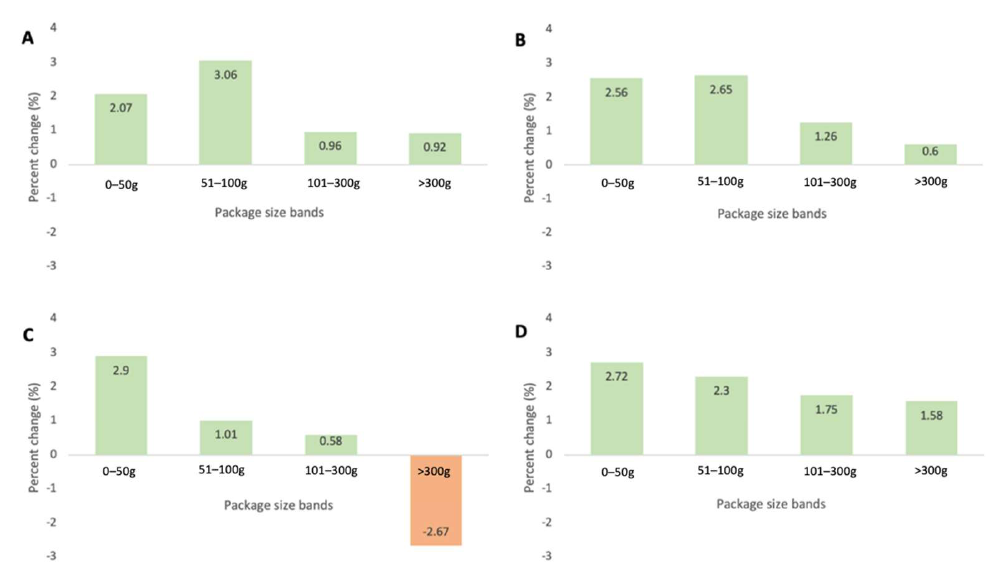
Figure 2. Compound annual growth rate (CAGR) per capita of savoury snack total sales from 2006 to 2020 according to package size bands in ( A ) Australia, ( B ) the USA, ( C ) Japan, and ( D ) Hong Kong .